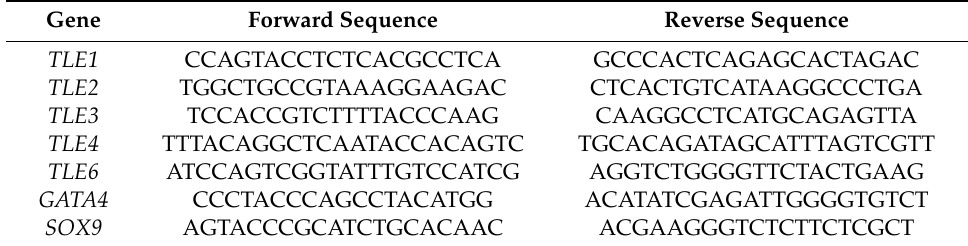
Table 1. Primer sequence for qRT-PCR